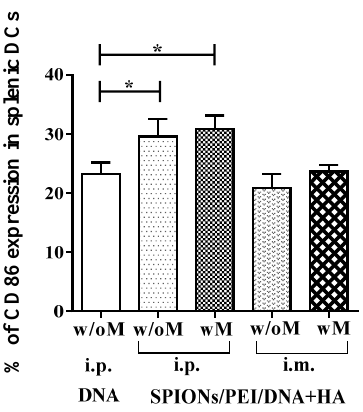
Figure 3. Dendritic cell activation in spleen after injection with SPIONs/PEI/DNA + HA complexes via i.p. or i.m. administration (naked DNA via i.p. only), with or without the application of a magnetic field. Mice (BALB/c) were injected once via i.p. or i.m. route of injection. Forty-eight hours after injection, mice were sacrificed, spleens were harvested, and the levels (%) of CD86 marker in splenic DCs were assessed by flow cytometry. Data are presented as mean percentage of CD86-positive DCs ± SD for each group of treatment ( n = 3 mice/group). Statistical analysis was performed via t -tests, * p ≤ 0.05.